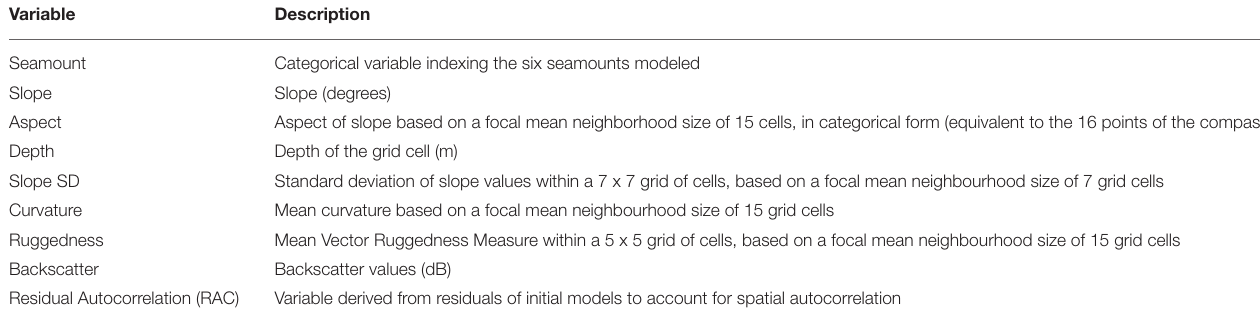
TABLE 3 | Final set of predictor variables used in the habitat suitability models.